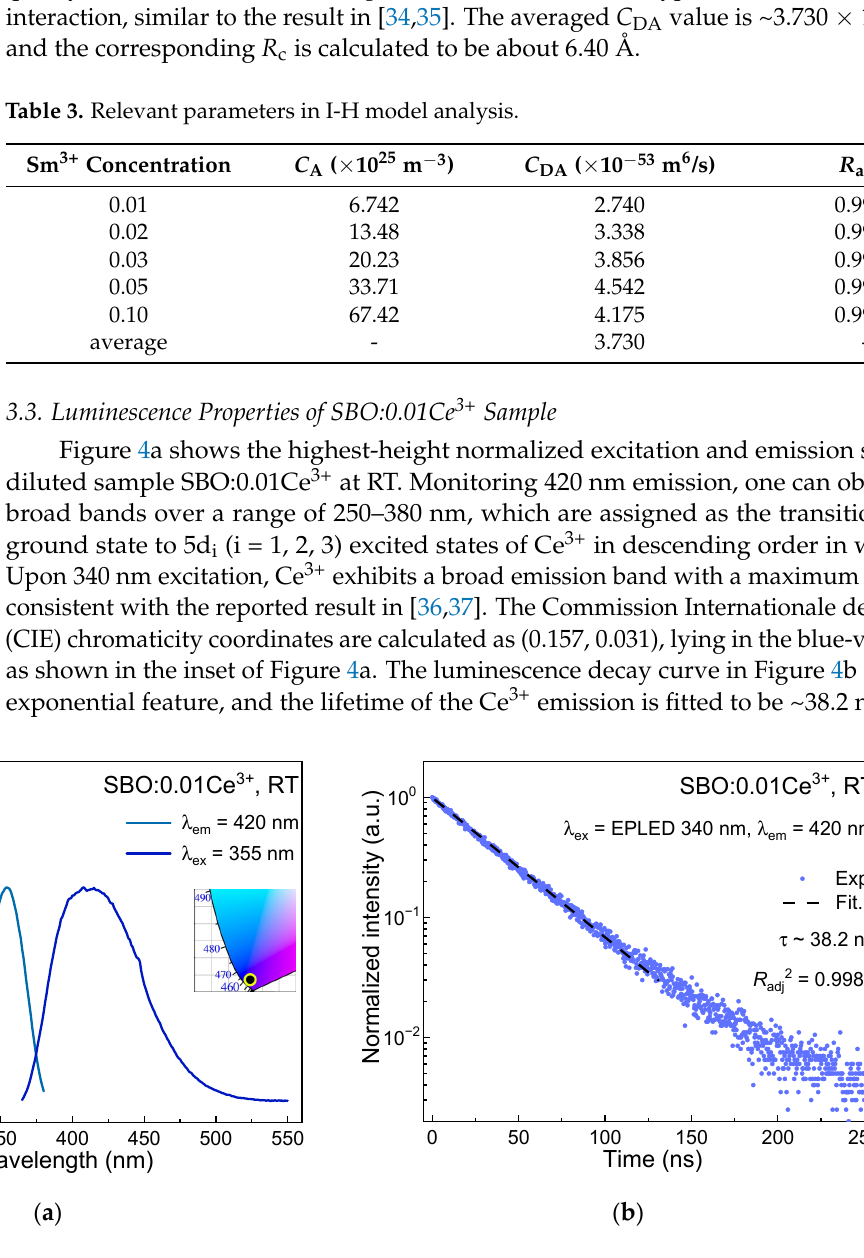
Figure 4. ( a ) The highest-height normalized excitation ( λ em = 420 nm) and emission ( λ ex = 340 nm) spectra of SBO:0.01Ce 3+ at RT. The inset displays the CIE chromaticity coordinates of the sample; ( b ) Luminescence decay curve ( λ ex = EPLED 340 nm, λ em = 420 nm) of SBO:0.01Ce 3+ at RT.